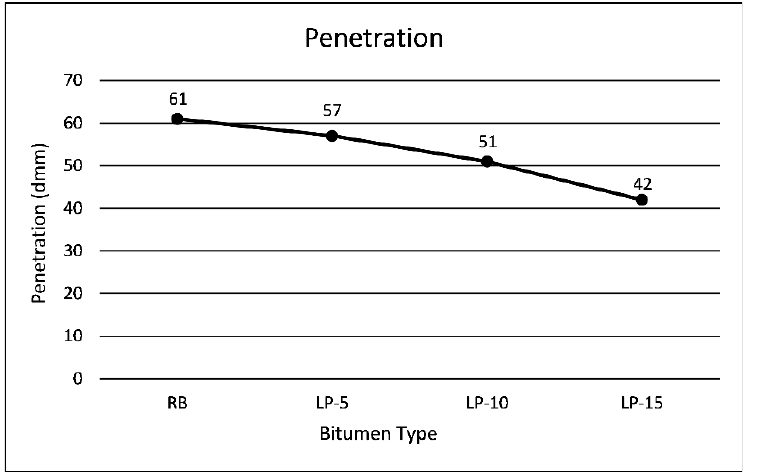
Figure 10. Penetration results .